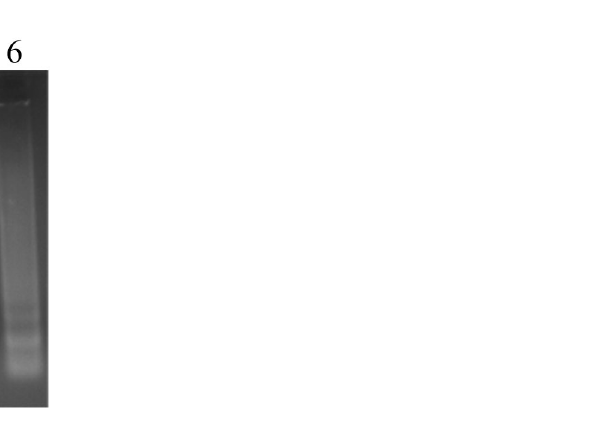
Figure 3. Analysis of ALV-J CPA at different concentration of Mg 2+ by agarose gel electrophoresis. Lane M, DNA marker; 1, 0 mmol L −1 ; 2, 1 mmol L −1 ; 3, 2 mmol L −1 ; 4, 3 mmol L −1 ; 5, 4 mmol L −1 ; 6, 5 mmol L −1 . The full- length gel is presented in Supplementary Figure S19.